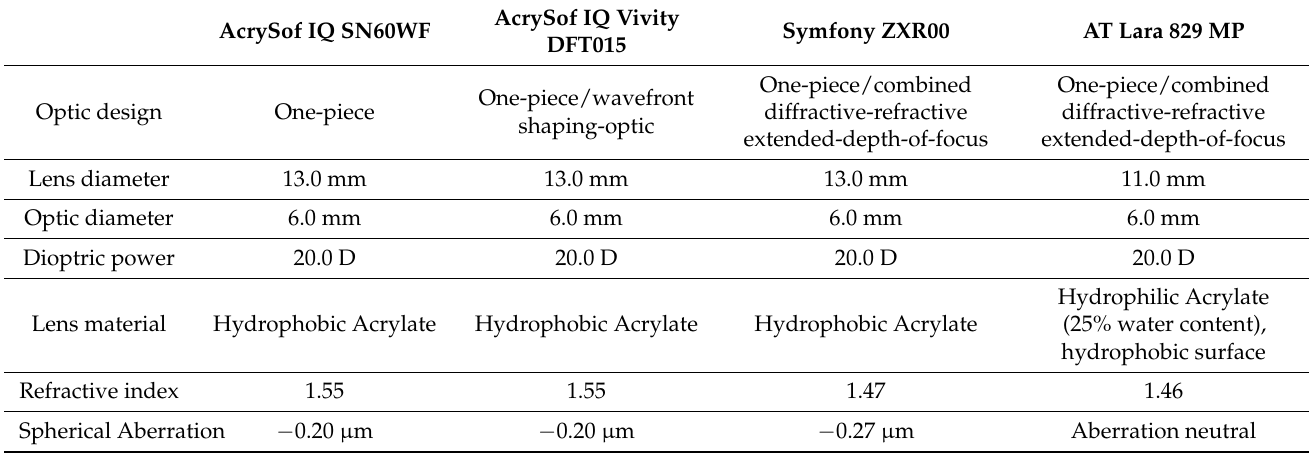
Table 1. Key characteristics of the tested intraocular